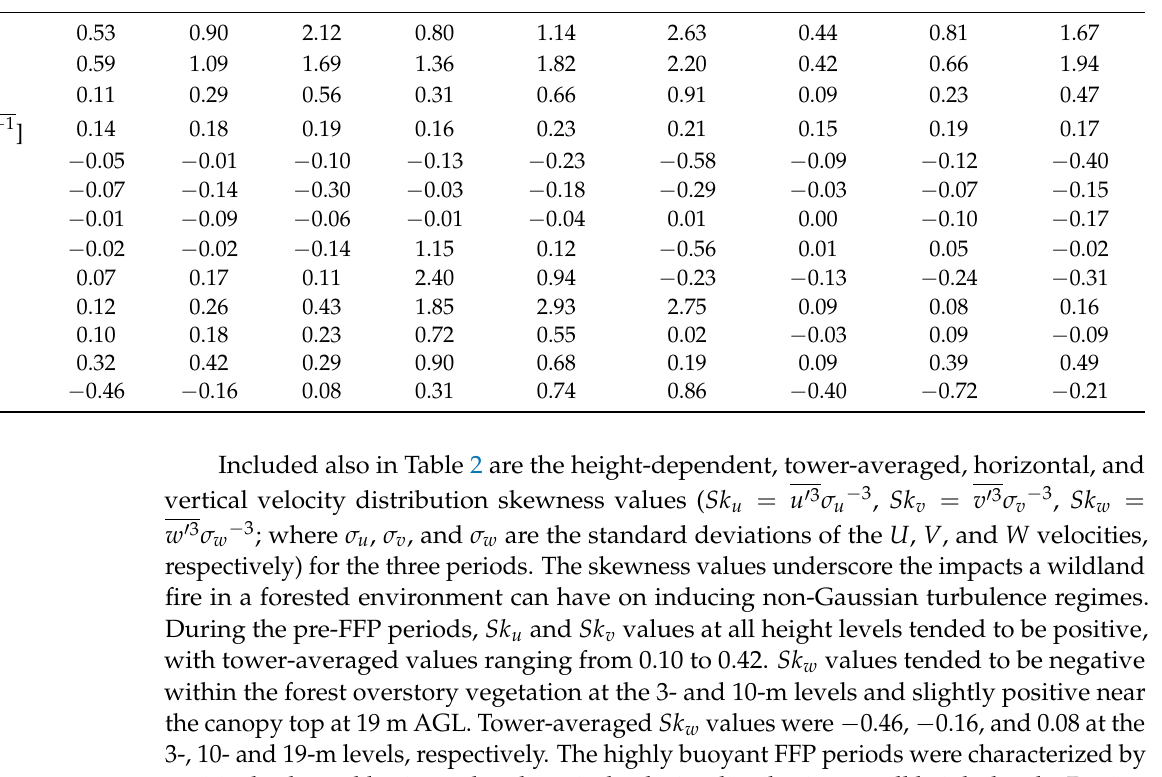
Table 2. Average turbulence statistics at the 3-m, 10-m, and 19-m levels within the pre-FFP, FFP, and post-FFP periods. Brackets indicate an average across all the in situ towers. Overbars indicate temporal means within each period. Units for the tower-averaged temporal mean TKE components ( u (cid:48) 2 , v (cid:48) 2 , w (cid:48) 2 ), kinematic momentum fluxes ( u (cid:48) v (cid:48) , u (cid:48) w (cid:48) , v (cid:48) w (cid:48) ), and kinematic heat fluxes ( u (cid:48) t (cid:48) , v (cid:48) t (cid:48) , w (cid:48) t (cid:48) ) are m 2 s − 2 , m 2 s − 2 , and m s − 1 ◦ C, respectively. Anisotropy values ( w (cid:48) 2 ( 2 ∗ TKE ) − 1 ) and skewness values for the horizontal and vertical velocity distributions ( Sk u , Sk v , Sk w ) are unitless.